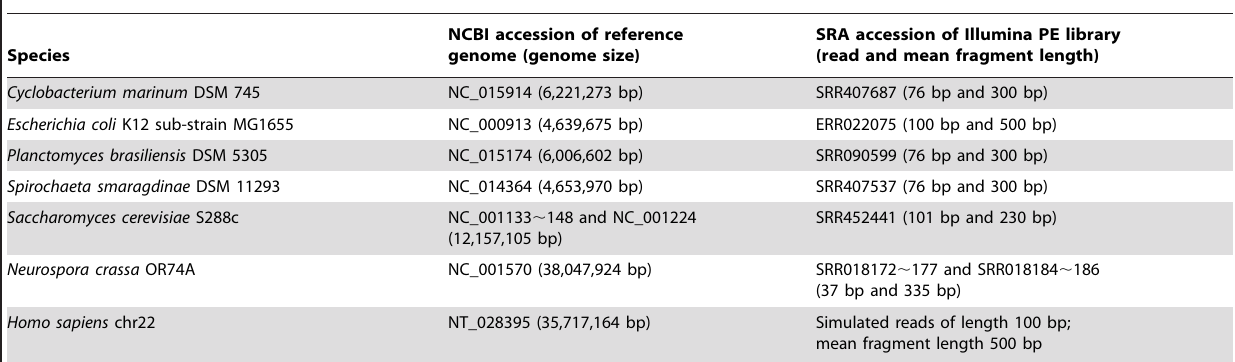
Table 1. Genomic sequences and NGS data used in this